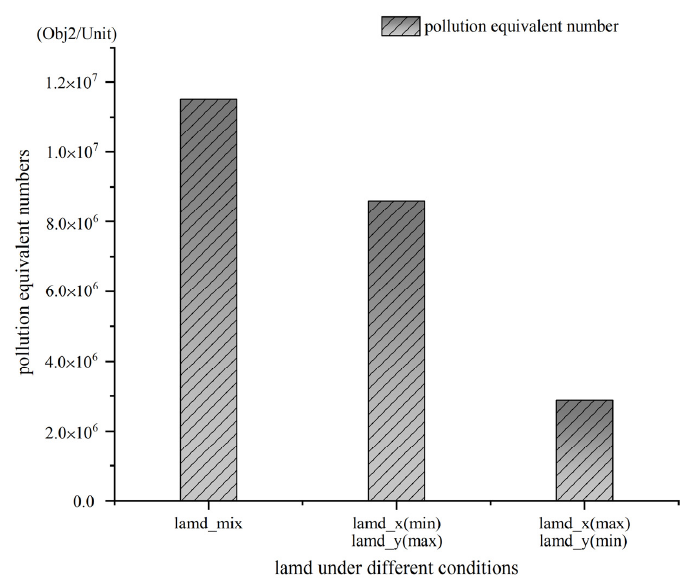
Figure 3. Pollution equivalents with attributes distinguished or not.